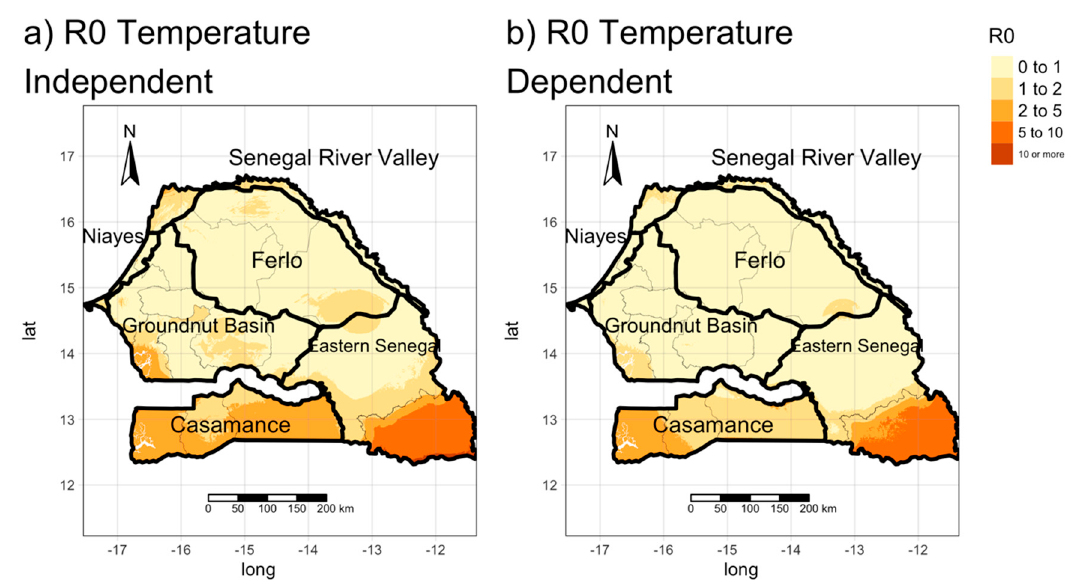
Figure 5. Transmission maps ( R 0 ) ( a ) realized using temperature-independent parameters; ( b ) using temperature-dependent parameters.